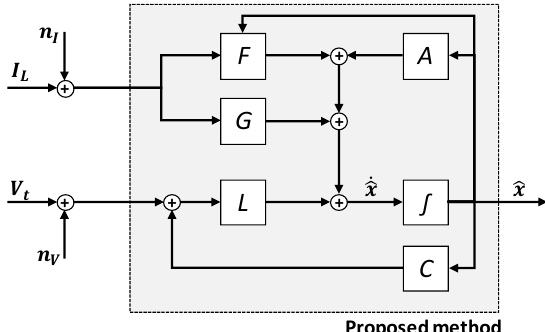
Figure 14. The block diagram of proposed method.